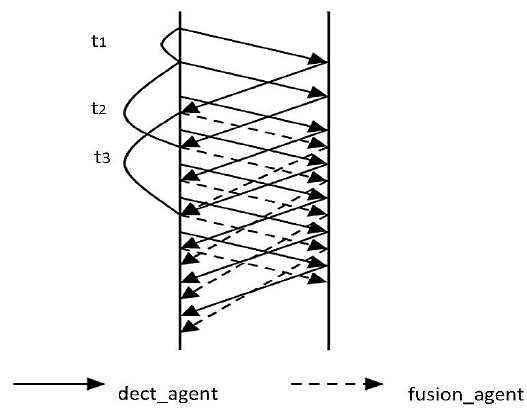
Figure 14. Multi mobile agent working time chart.